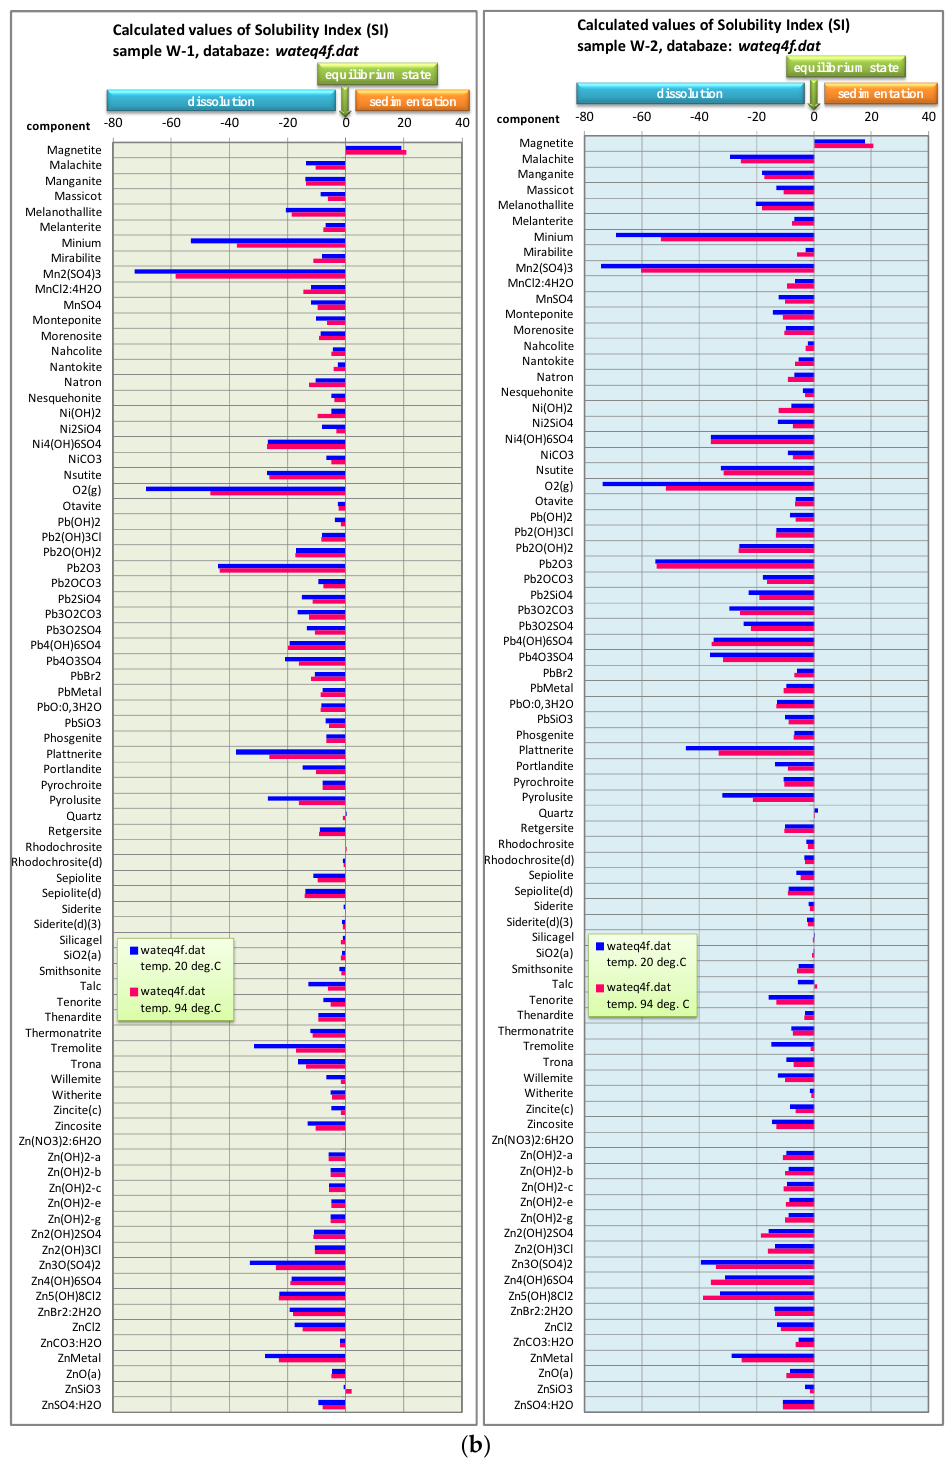
Figure 6. ( a ) Comparison of SI calculated for W-1 and W-2 water samples using wateq4f.dat database at 20 °C (ambient) and 94 °C (deposit) temperatures. ( b ) Comparison of SI calculated for W-1 and W-2 water samples using wateq4f.dat database at 20 °C (ambient) and 94 °C (deposit) temperatures.